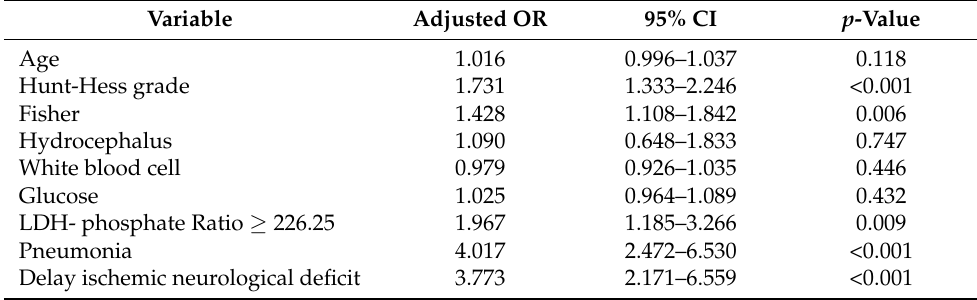
Figure 6. ROC curve of the three predictors. Predictive values of LDH-phosphate Ratio for 3-month modified Rankin Scale (mRS) >2 area under curve 0.713 (the cutoff = 226.25, 95% CI, 0.681 – 0.743; p < 0.001; the sensitivity was 63.33%, and the specificity was 74.18%). The AUC of LDH and phosphate were 0.698 (95% CI 0.666 – 0.729, p < 0.001; the sensitivity was 59.17%, and the specificity was 75.95%), 0.630 (95% CI 0.597 – 0.662, p < 0.001; the sensitivity was 45.00%, and the specificity was 76.77%), respectively.